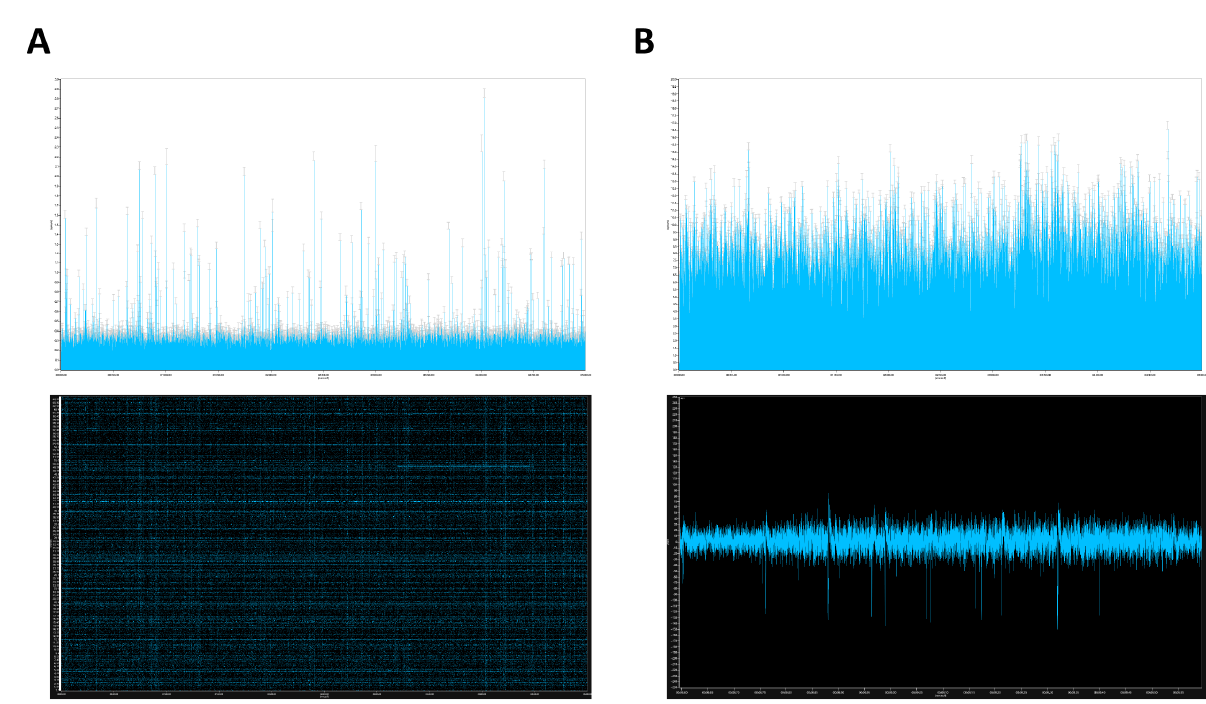
Figure 7. Basal spontaneous networked activity and presence of a subpopulation of strongly active hiPSC-derived MNs in 8-weeks mature cultures. ( A ) AFR of 4096 channels over 5 min of recording (top panel) and related raster plot (bottom panel). ( B ) AFR of the 64 most active channels out of 4096 (top panel) and a representative trace of a single channel showing multiple spikes within 1 s of recording (bottom panel).